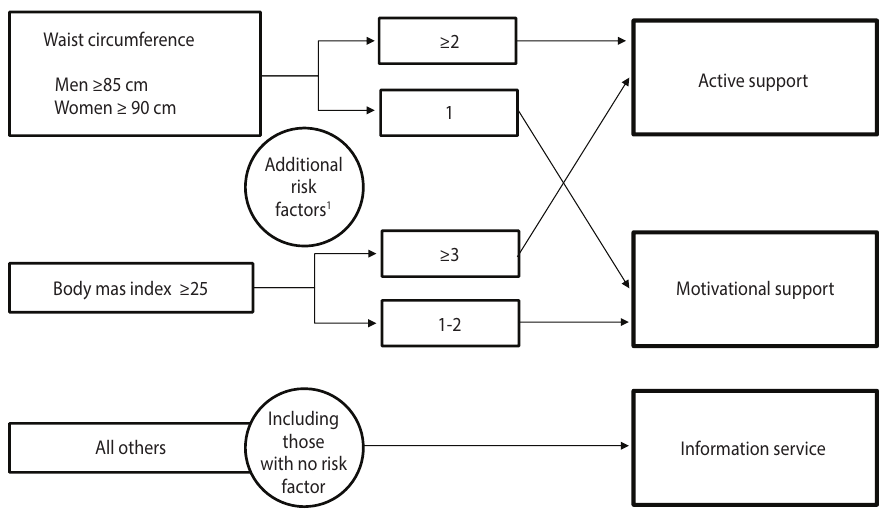
Figure 2. Current system of post-screening measures for metabolic syndrome. 1 Additional risk factors: hyperglycemia (FBS ≥100 mg/dL or HbA1c ≥5.6%); dyslipidemia (TG ≥150 mg/dL or HDL ≤40 mg/dL); hypertension (SBP ≥130 mmHg or DBP ≥ 85 mmHg); Smoking. FBS, fast- ing blood sugar; HbAlc, glycated hemoglobin; TG, triglyceride; HDL, high-density lipoprotein cholesterol; SBP, systolic blood pressure; DBP, diastolic blood